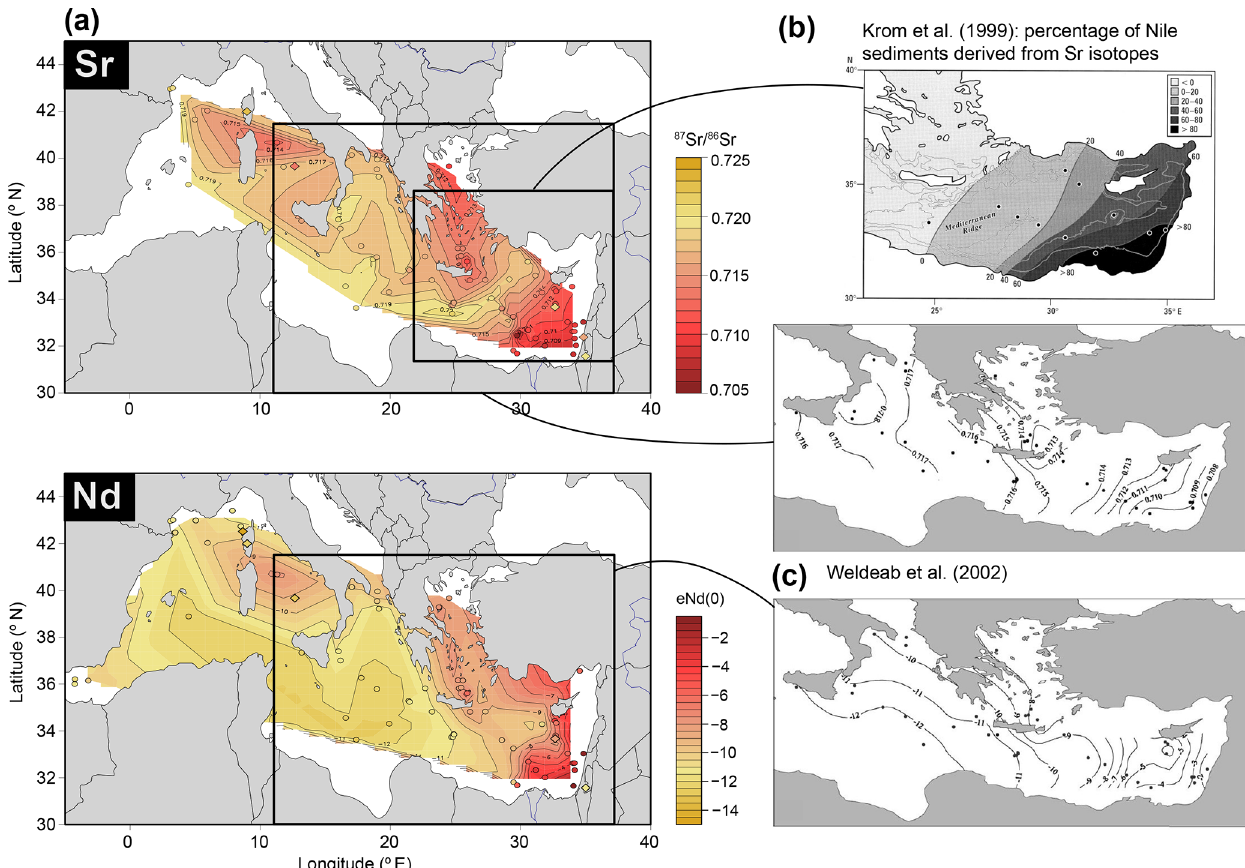
Figure 2. Contour maps of the isotopic signature of marine surface sediments in the Mediterranean. (a) Contour maps produced using the assembled dataset for strontium and neodymium isotopes. The contour lines and filled contour maps were realized using individual surface (or core-top) sediment samples. Each sample is represented by a dot whose colour indicates its isotopic value according to the scale at the right of the panels. Aerosol samples are overlaid and represented by a diamond with a similar colour code. These maps are compared to previous contour maps from Krom et al. (1999b) (where the Sr isotopes calculate a percentage of surface sediments derived from the Nile River runoff) (b) and Weldeab et al. (2002a) (c) , which were inspirational to this work. Their respective extent is reported on the maps in (a)